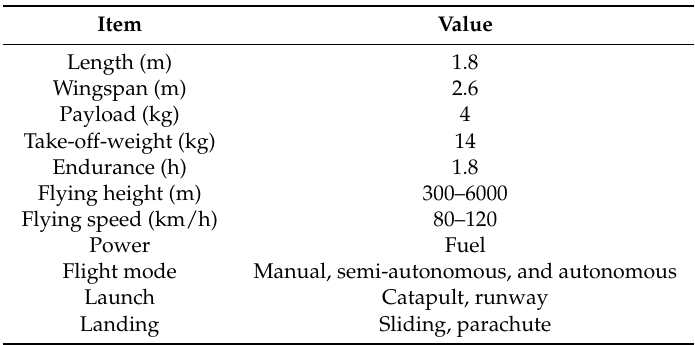
Figure 3. The study area and the UAV flight path. Table 1. Technical specifications of the UAV platform used in the experiment